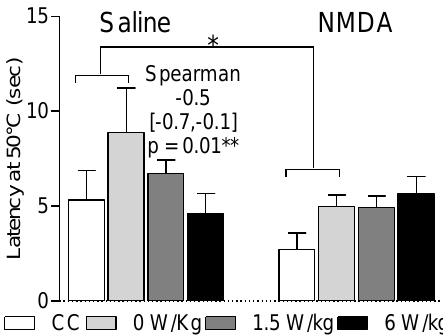
Figure 2. Faster escape from the hot plate in correlation with the BASARs. Sham-exposed and RF-EMF-exposed groups were tested in the two temperatures choice test following i.t. saline or NMDA injection. * p < 0.05, escape from the hot plate was faster in the NMDA compared to the saline treated rats. ** p = 0.01. Escape from the hot plate was faster in correlation with the BASARs in the saline group but not in the NMDA group. N = 6–12 rats/group.